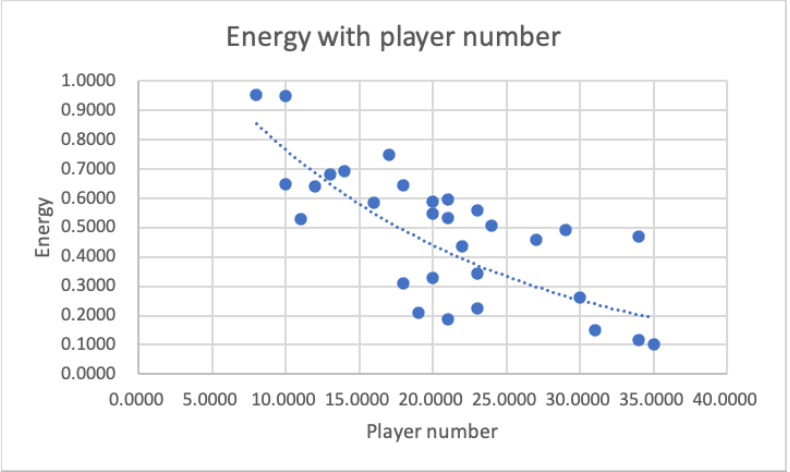
Figure 3. Energy changes with player number.